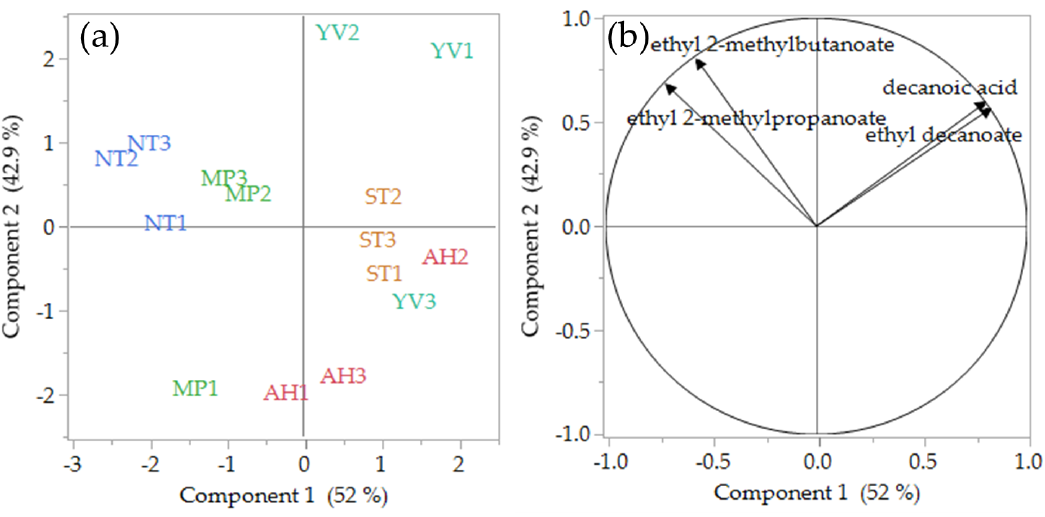
Figure 1. Principal component analysis (PCA) scores ( a ) and loadings ( b ) plots of 2018 Pinot noir wines ( n = 3 per region) and significant ( p < 0.05) volatile compounds. AH, Adelaide Hills; MP, Mornington Peninsula; YV, Yarra Valley; ST, Southern Tasmania; NT, Northern Tasmania.